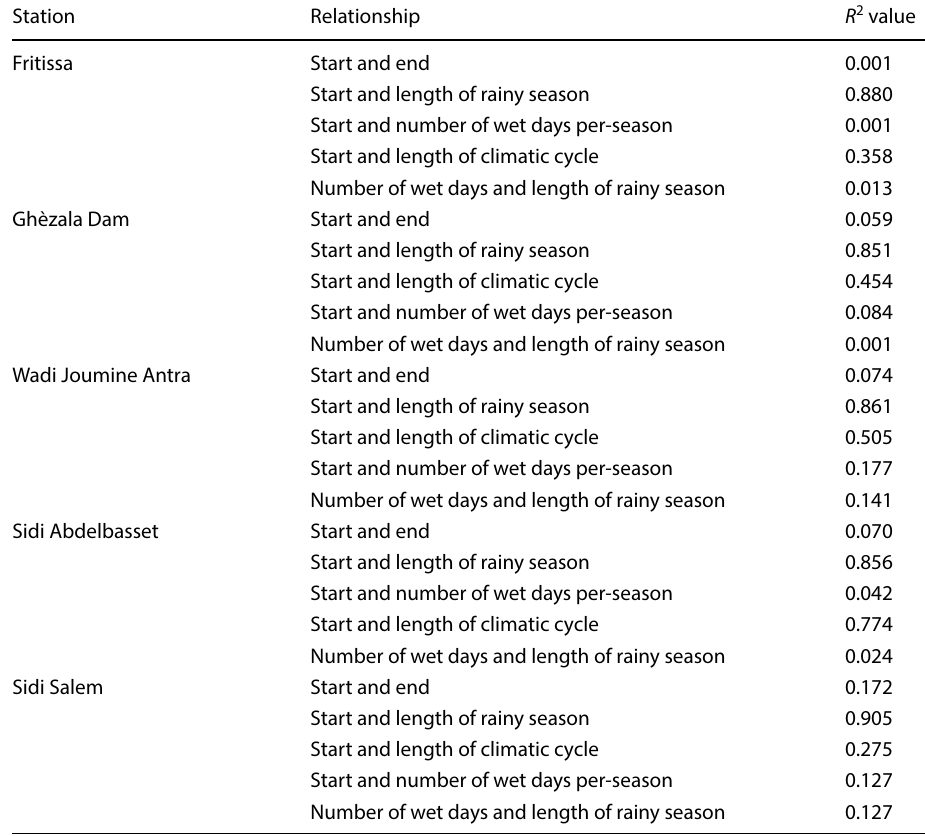
Table 19 Relationships of the different characteristics of the rainy season in Ichkeul lake basin